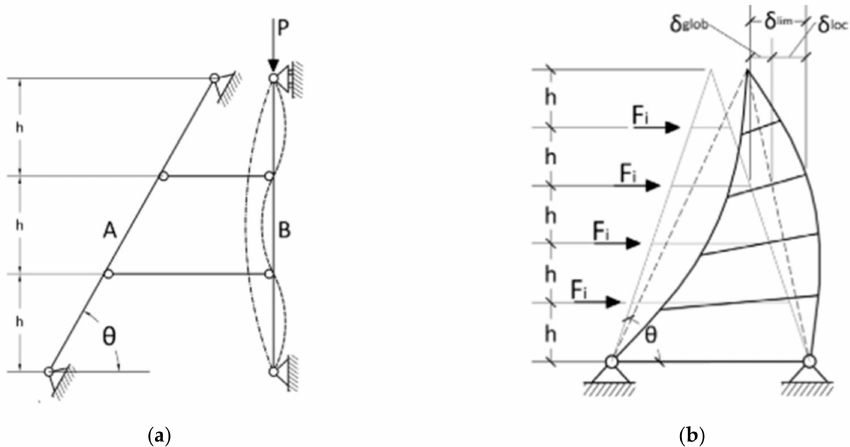
Figure 13. Local issues in the design of diagrid tall buildings: ( a ) stability of interior columns; ( b ) excessive inter-story drift of intra-module floors. Used with permission from Montuori et al.